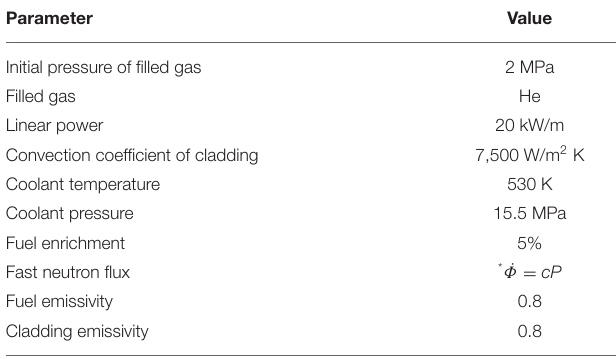
TABLE 1 | Operation